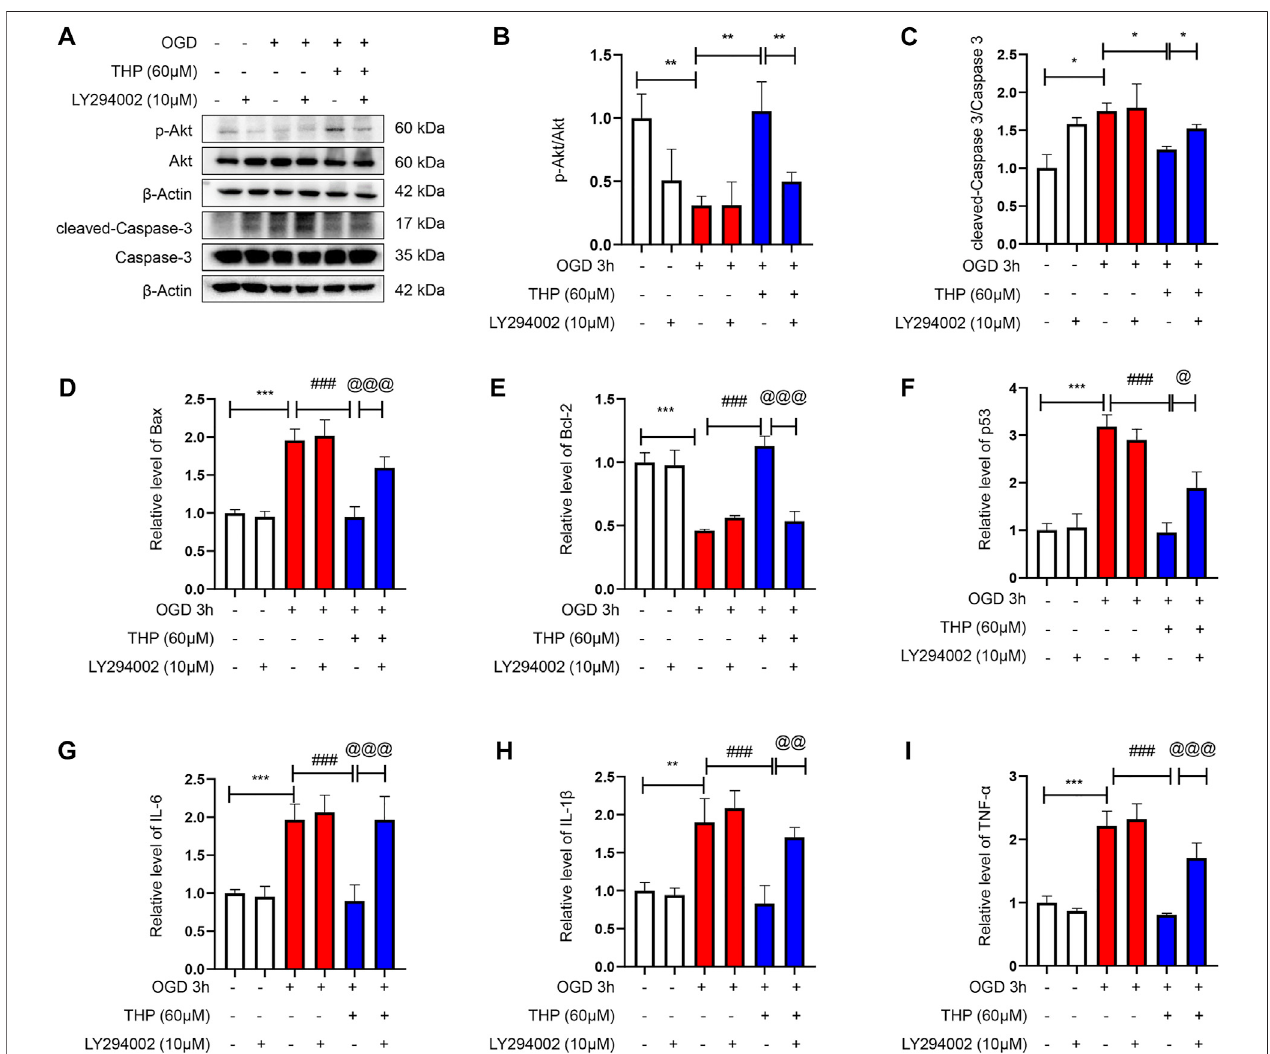
FIGURE 9 | THP exhibited anti-apoptotic effect and suppressed the expression of in fl ammatory factors via regulating the PI3K/Akt signaling pathway. H9c2 cells were incubated with LY294002 (10 μ M, diluted in DMSO), an inhibitor of the PI3K/Akt pathway or treated with THP (60 μ M) for 48 h, and then the cells were stimulated with OGD. (A – C) The protein expressions of p-Akt, total Akt, cleaved caspase-3, and caspase-3. (D – F) The mRNA expressions of apoptosis factors (Bax, Bcl-2, and p53). (G – I) The mRNA expressions of in fl ammatory factors (IL-6, IL-1 β , and TNF- α ). Data are shown as the mean ± SD. * p < 0.05, ** p < 0.01, *** p < 0.001 vs. control; # p < 0.05, ## p < 0.01, ### p < 0.001 vs. OGD, @ p < 0.05, @@ p < 0.01, @@@ p < 0.001 vs. OGD + THP. n = 3 (three independent